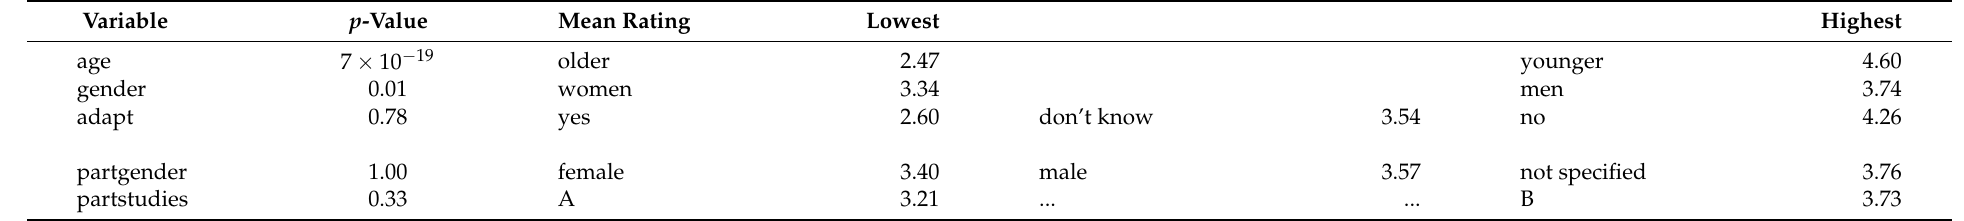
Table A3. Likelihood of use for Desktop computer (PC), p -value from ANOVA with associated mean